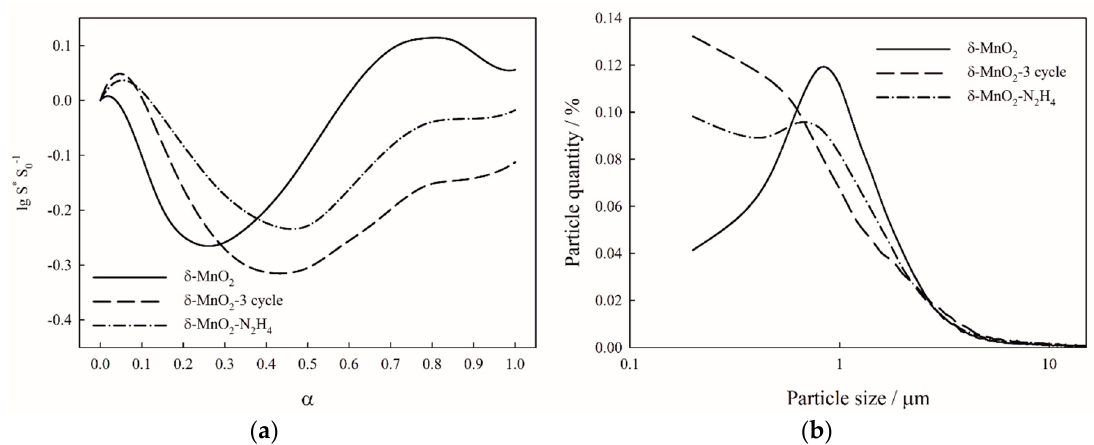
Figure 6. Specific surface area curves vs. degree of conversion α ( a ) and particle size distributions ( b ) of the studied birnessites.